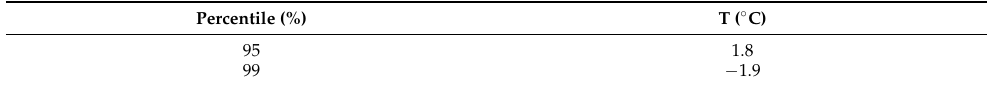
Table 3. Percentiles Madrid—Spain.